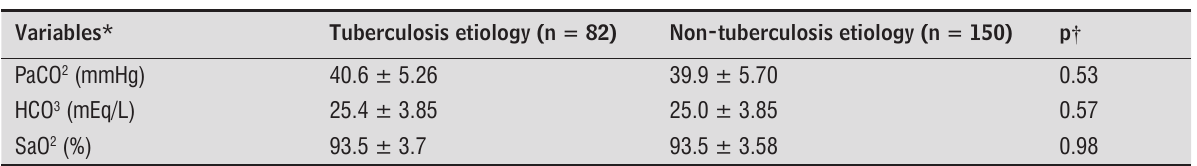
Table 5 – Forced spirometry and blood gases analysis in patients with non-cystic fibrosis bronchiectasis according to etiology (tubercu- losis versus